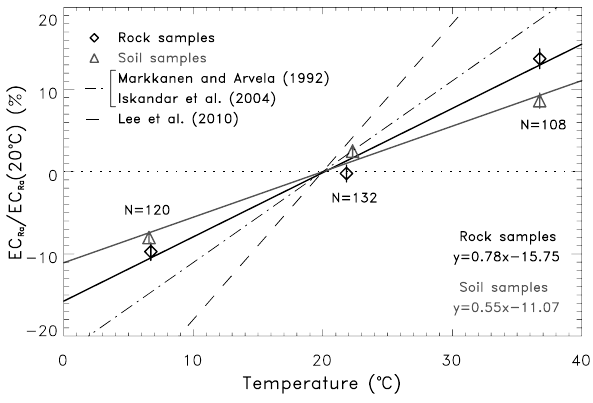
Fig. 5. Weighted average of all EC Ra values as a function of temperature, rock samples (black diamonds) and soil samples (grey triangles) separately, normalized by the fitted value at 20 ◦ C, and expressed as the deviation from 1 in%. N represents the total number of measurements carried out for both rock and soil samples at each temperature stage. Their respective linear fit (solid lines) and associated equation are displayed. The linear trends obtained in three previous studies (Markkanen and Arvela, 1992; Iskandar et al., 2004; Lee et al., 2010) are also plotted for comparison (dashed